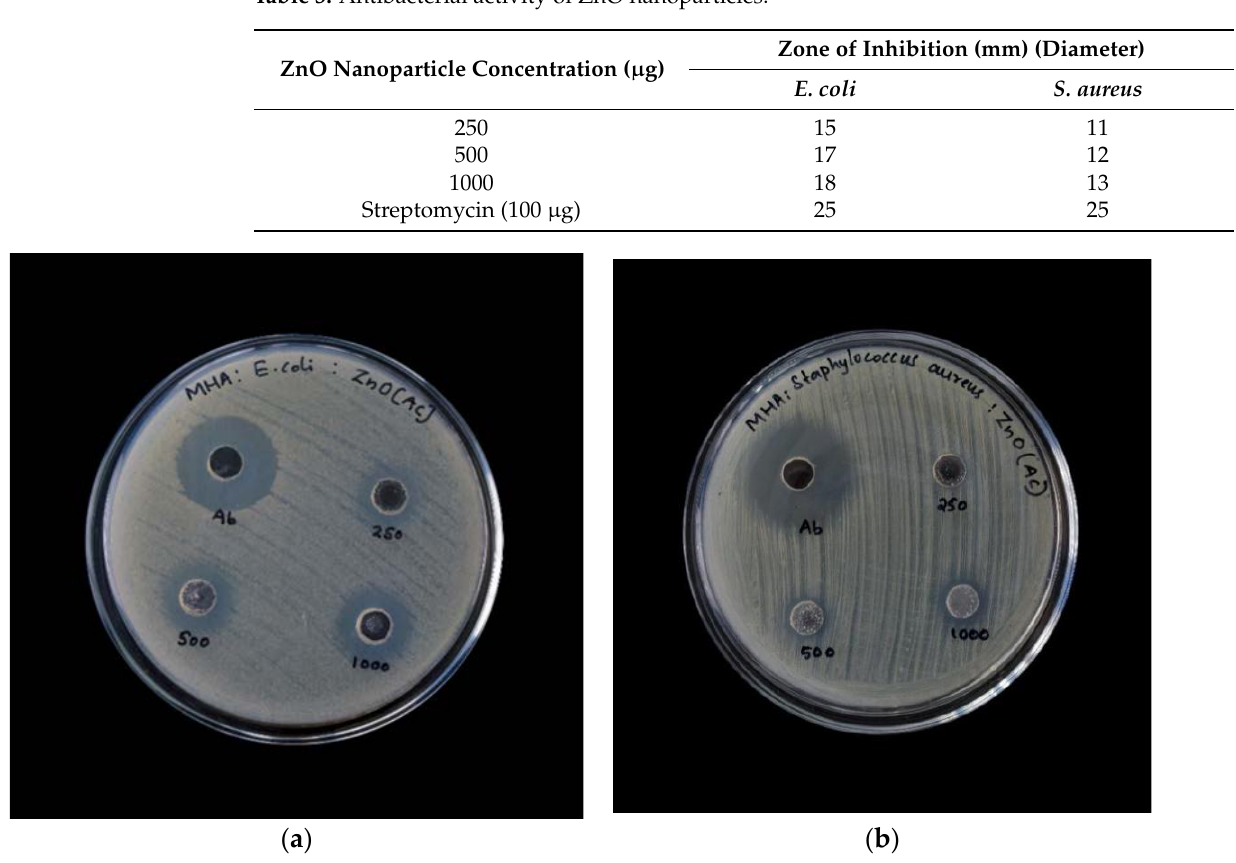
Figure 10. Antibacterial activity of ZnO nanoparticles against ( a ) E. coli and ( b ) S. aureus.